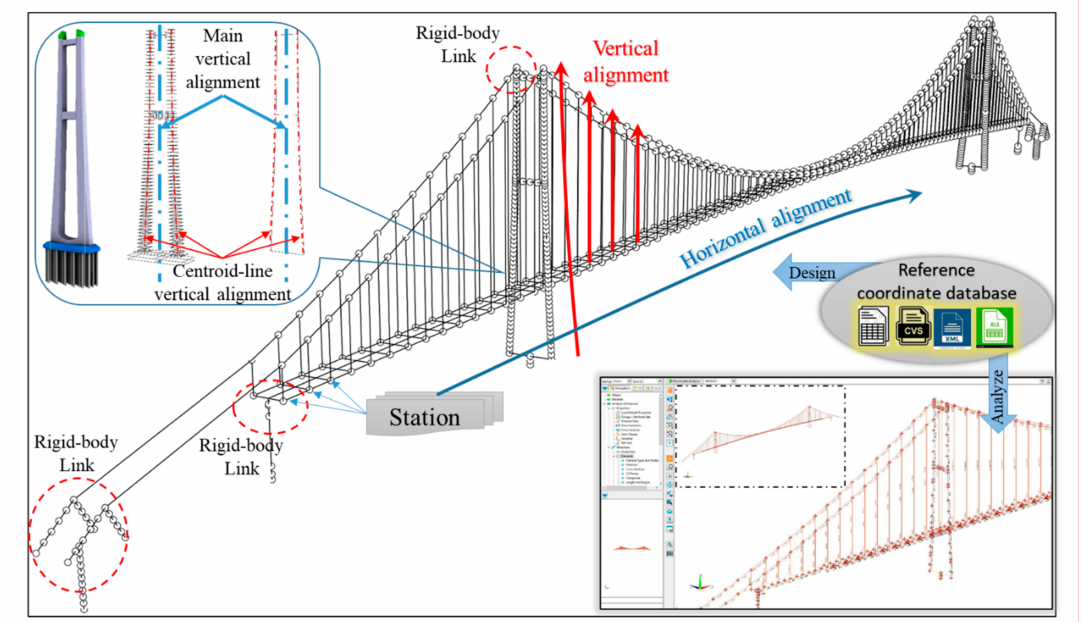
Figure 10. Bridge alignment for a suspension